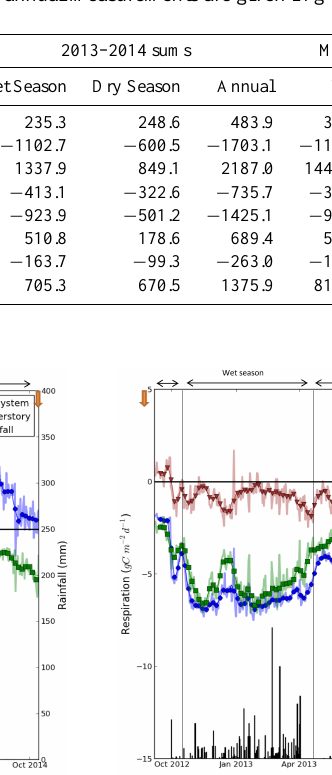
Table 3. Seasonal sums and annual mean ( ± SE) of net ecosystem productivity (NEP), respiration ( R ) and gross primary productivity (GPP) calculated for the savanna ecosystem, understory and overstory components at the Howard Springs OzFlux site, Northern Territory, Australia.